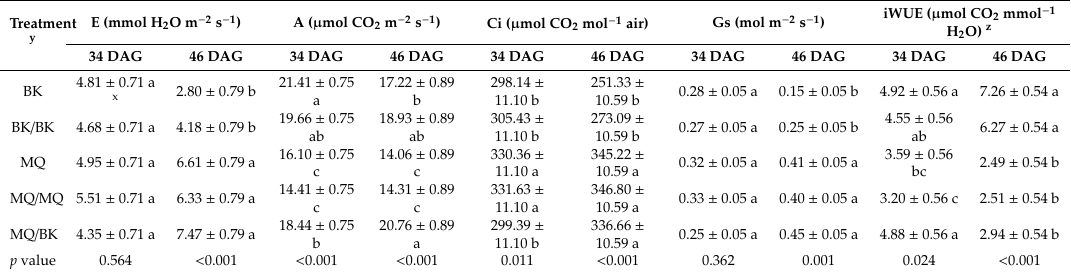
Table 3. Leaf transpiration rate (E), net CO 2 assimilation rate (A), intercellular CO 2 concentration (Ci), stomatal conductance (gs), and instantaneous water use e ffi ciency (iWUE) of grafted, self-grafted, and non-grafted pac choi and daikon radish plants at 34 d after grafting (DAG) and 46 DAG in the 2019